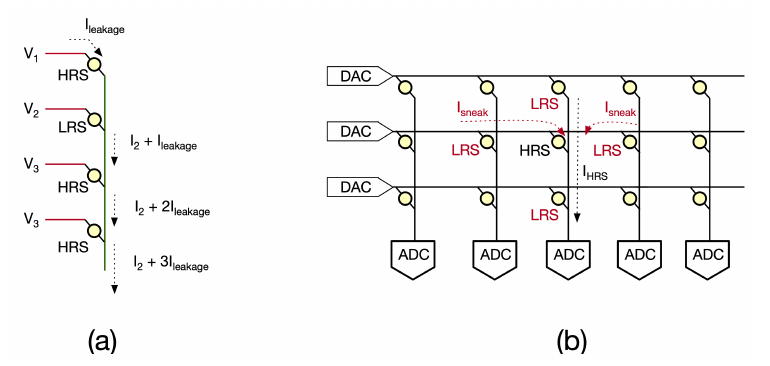
Figure 6. ( a ) Leakage current. ( b ) Sneak